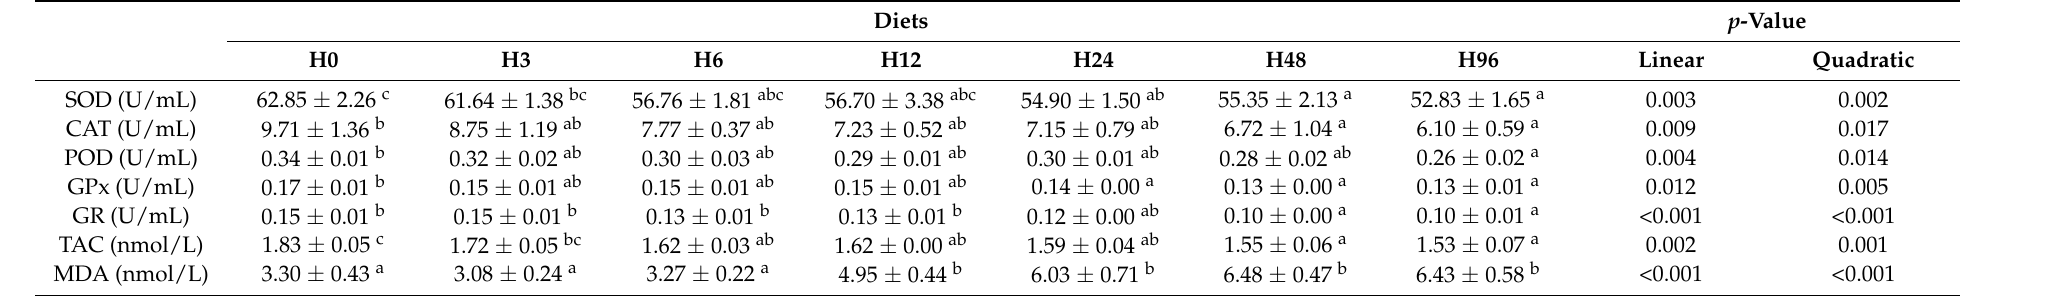
Table 6. Effect of dietary histamine content on the antioxidant-related index in the serum of the hybrid grouper.